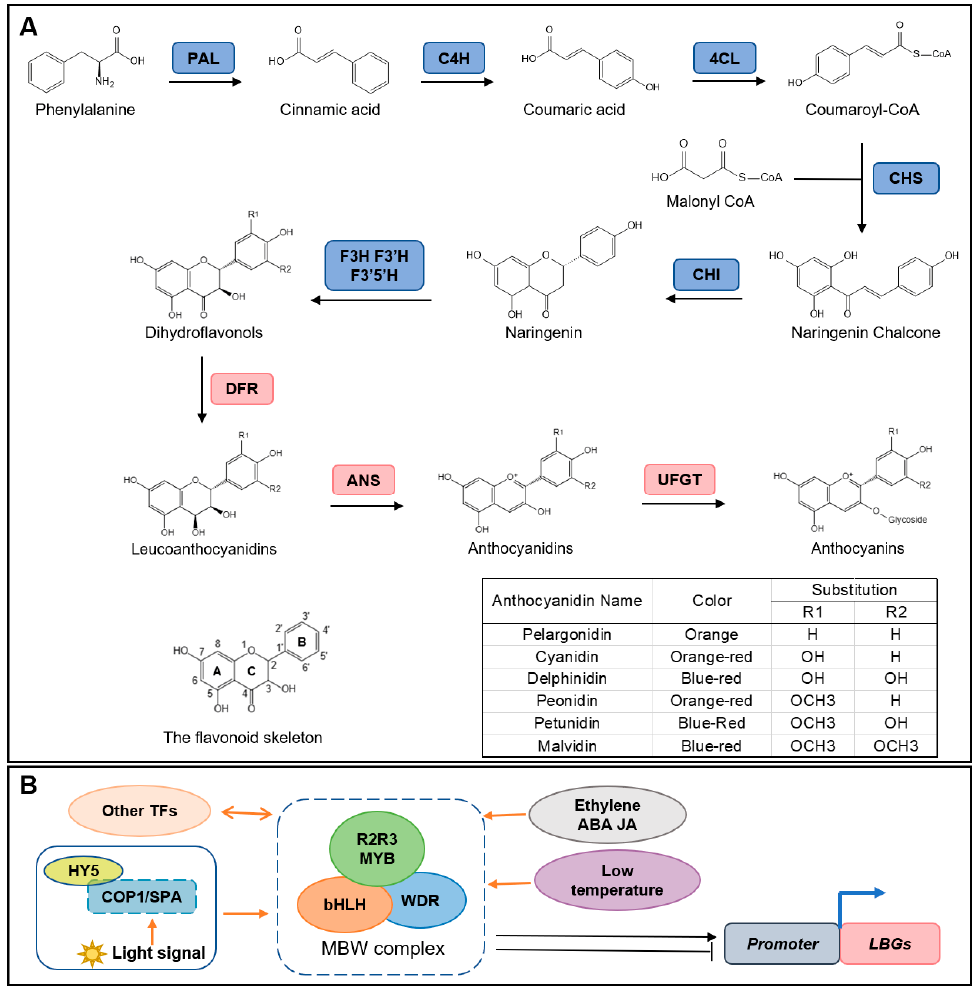
Figure 1. Anthocyanin biosynthesis pathway and the regulation factors. ( A ) Schematic pathway of anthocyanin biosynthesis in plants and the chemical structure of anthocyanins. Blue and light-red boxes represent EBGs and LBGs . ( B ) Other factors regulate anthocyanin accumulation in plants through affecting the MBW complex. The key LBGs DFR , ANS and UFGT are mainly regulated by a conserved MYB-bHLH-WDR (MBW) complex. The MBW complex interacts with other transcrip- tional factors and is regulated by phytohormones including ethylene, ABA (abscisic acid) and JA (jasmonic acid). The environment factors temperature and light signal affect the activity of the MBW complex. PAL, phenylalanine ammonia lyase; C4H, cinnamate 4-hydroxylase; 4CL, cinnamic